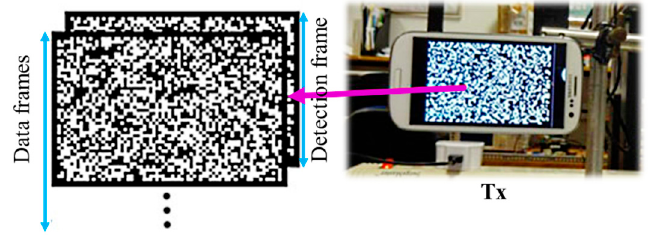
Figure 30. A screen-based TX for SVLC [38].